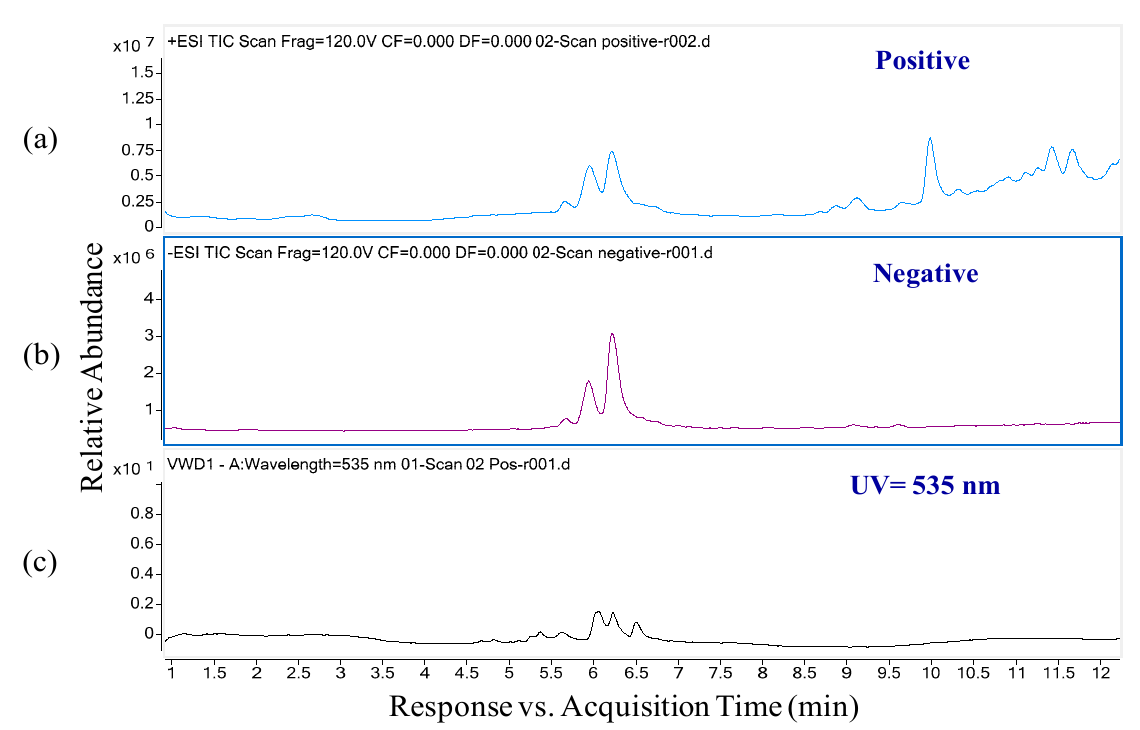
Figure 1. Total ion chromatograms in positive mode ( a ) and negative mode ( b ) and the corresponding chromatogram of UV at 535 nm ( c ).